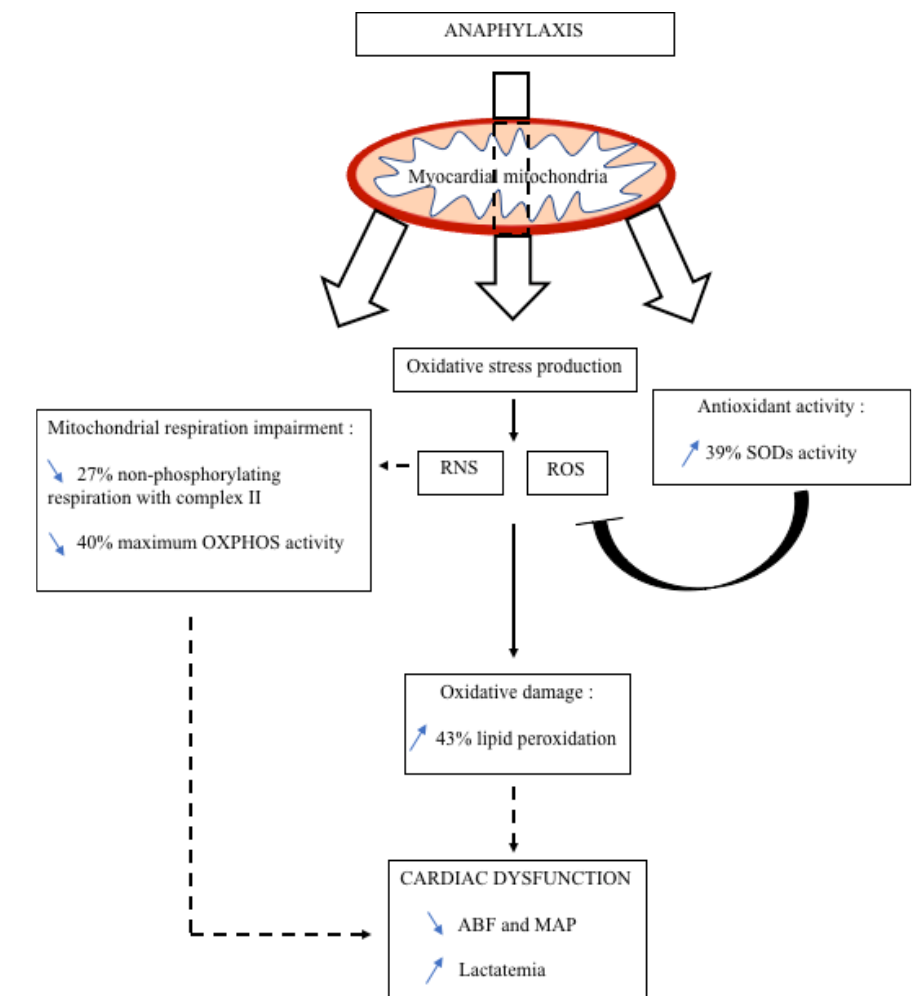
Figure 6. Illustration of anaphylaxis–suspected pathophysiological mechanisms involving myocardial mitochondrial dysfunction leading at least in part of cardiac dysfunction described in AS. In this study, AS leads to mitochondrial respiration impairment at T15 min in non-phosphorylating respiration with complex II and in maximum OXPHOS activity, which might alter cardiac function. AS-induced oxidative stress leads to oxidative damage with an increase in lipid peroxidation that might similarly impair cardiac function probably through NO-pathway, and its nitrative species as peroxynitrite, and less through ROS because of scavenging by the increase in SODs activity. Complete arrows: relationship based on results of this study. Dotted arrows: relationships based on the